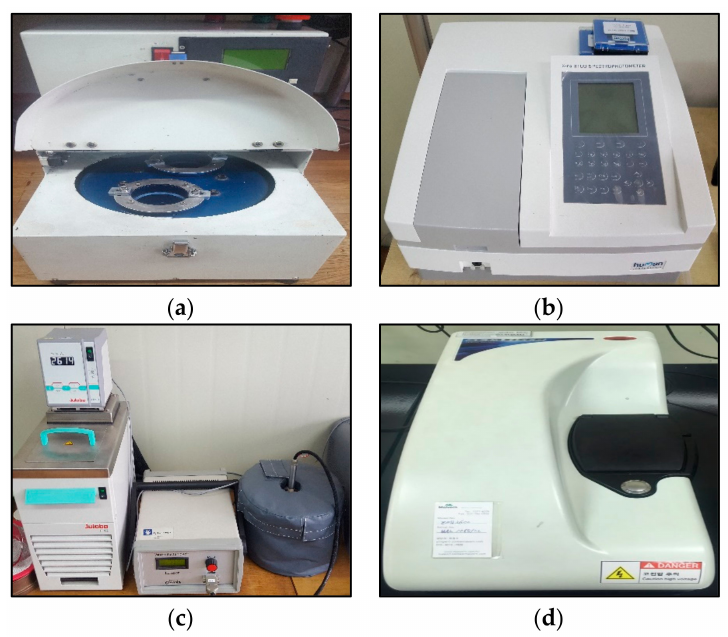
Figure 1. Photograph of measurement equipment: ( a ) planetary ball mill; ( b ) UV-vis spectrophotometer; ( c ) thermal Conductivity measuring system LAMBDA; ( d ) Zetasizer Nano ZS.